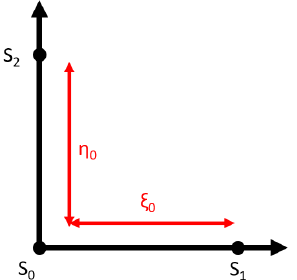
Figure 12. A schematic of the FCA setup. The pattern being probed is assumed to decay in the x and y directions in a generally anisotropic way, as well as evolving in time and travelling with a bulk motion. Three sensors ( S 0 , S 1 and S 2 ) are located at the origin, a distance ξ 0 away in the x direction and a distance η 0 away in the y direction, respectively (these represent the antennae for radar appli- cations). Each sensor records the local pattern strength continuously in